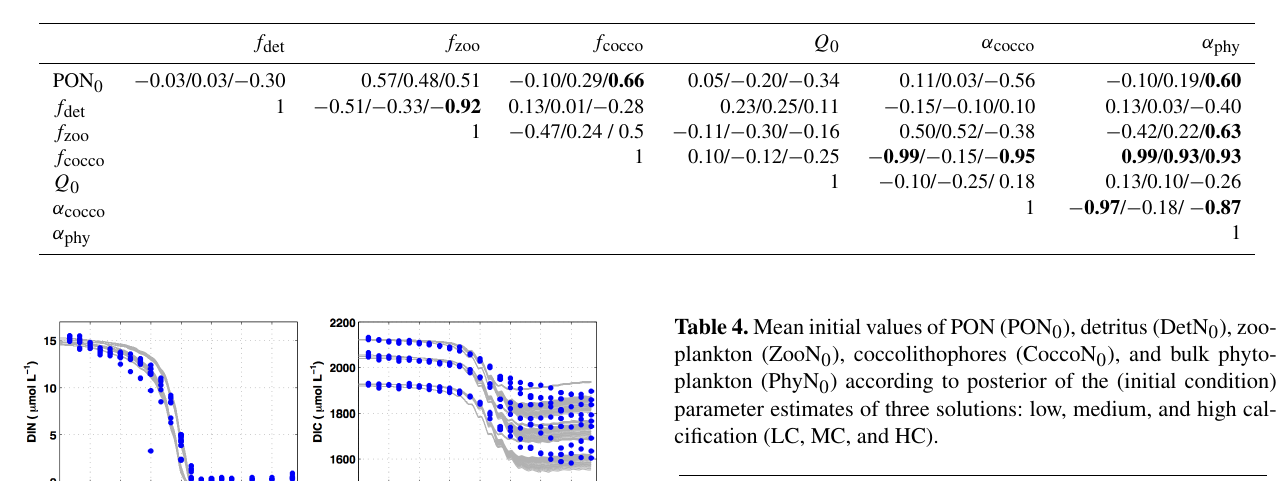
Table 3. Correlation coefficients of parameter estimates of low, medium, and high calcification model solutions (LC, MC, and HC). Corre- lation coefficients ≥ 0.6 are marked bold face.